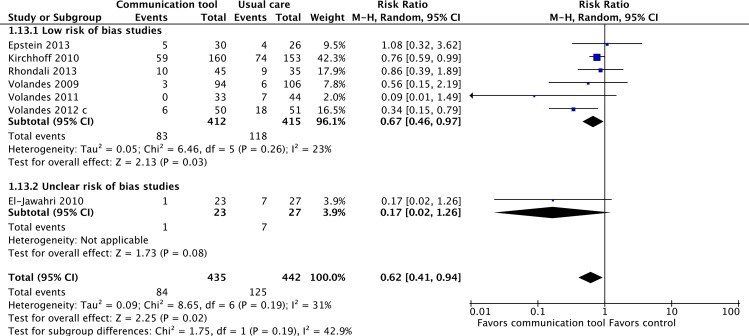
Patient preferences for life-prolonging as opposed to comfort care.